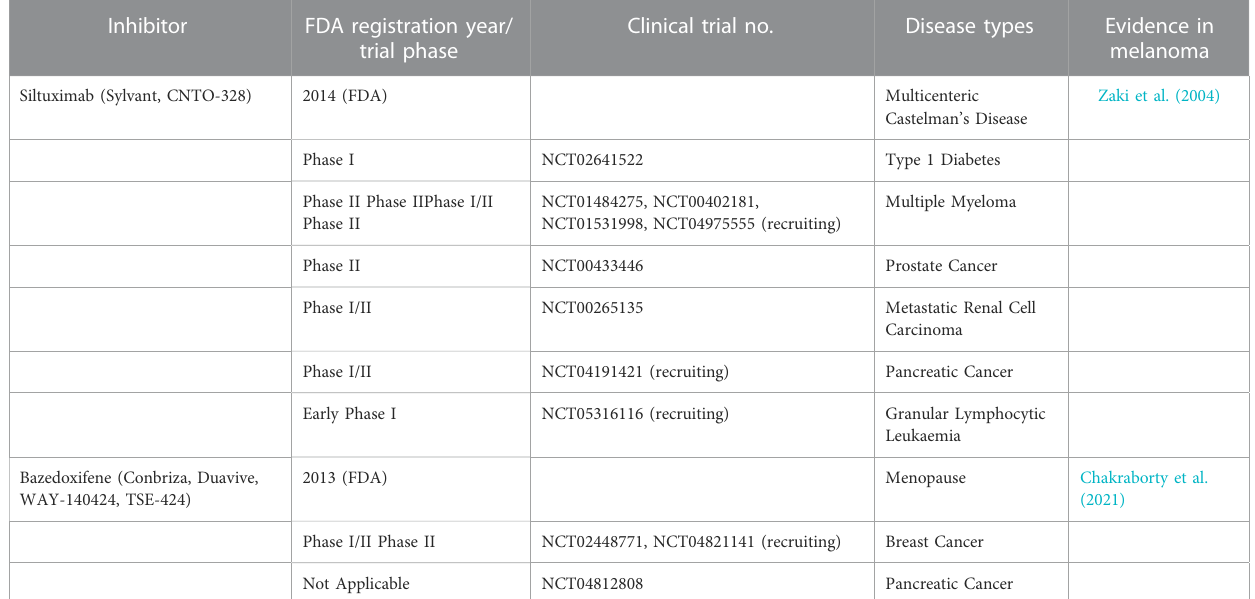
TABLE 4 IL-6 inhibitors.